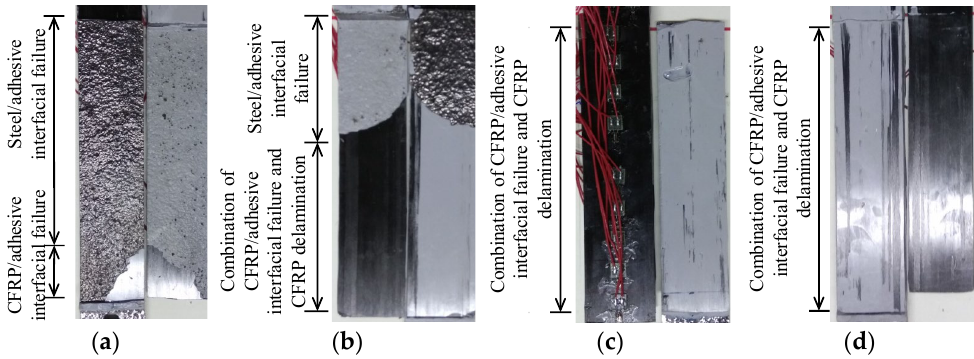
Figure 4. Effect of adhesive thickness on the failure modes for the specimens with the same corrosion duration. ( a ) C6-B5-T1 (back), ( b ) C6-B5-T2 (back), ( c ) C6-B5-T3 (front), ( d ) C6-B5-T4 (back).